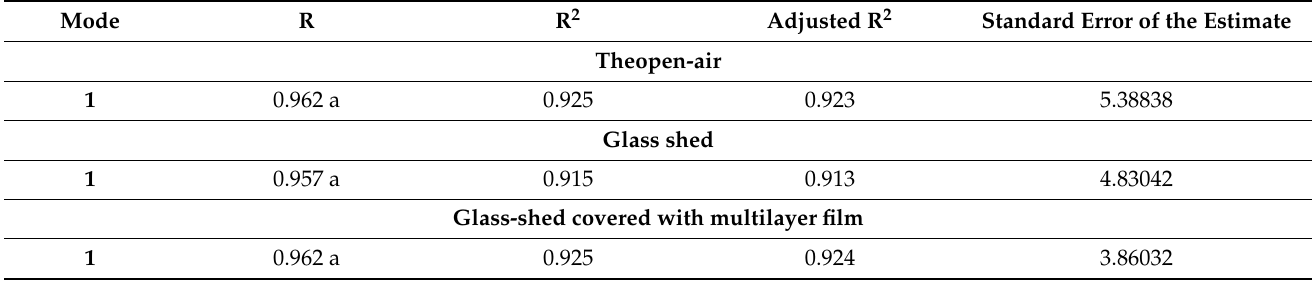
Table 2. The output of the SPSS shows the model Summary (b) of the three treatments.